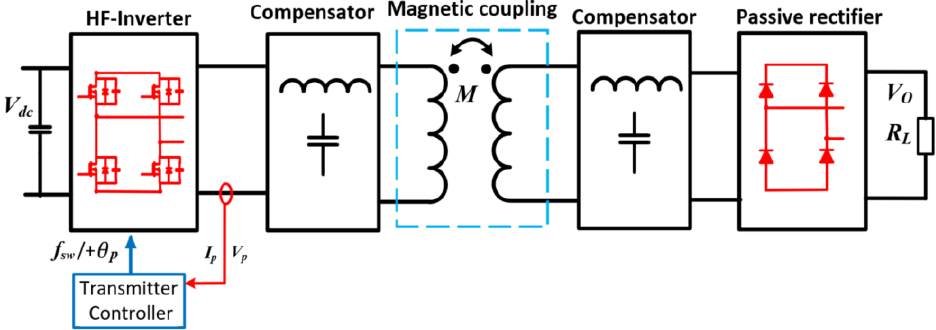
Figure 14. PE structure with frequency control.